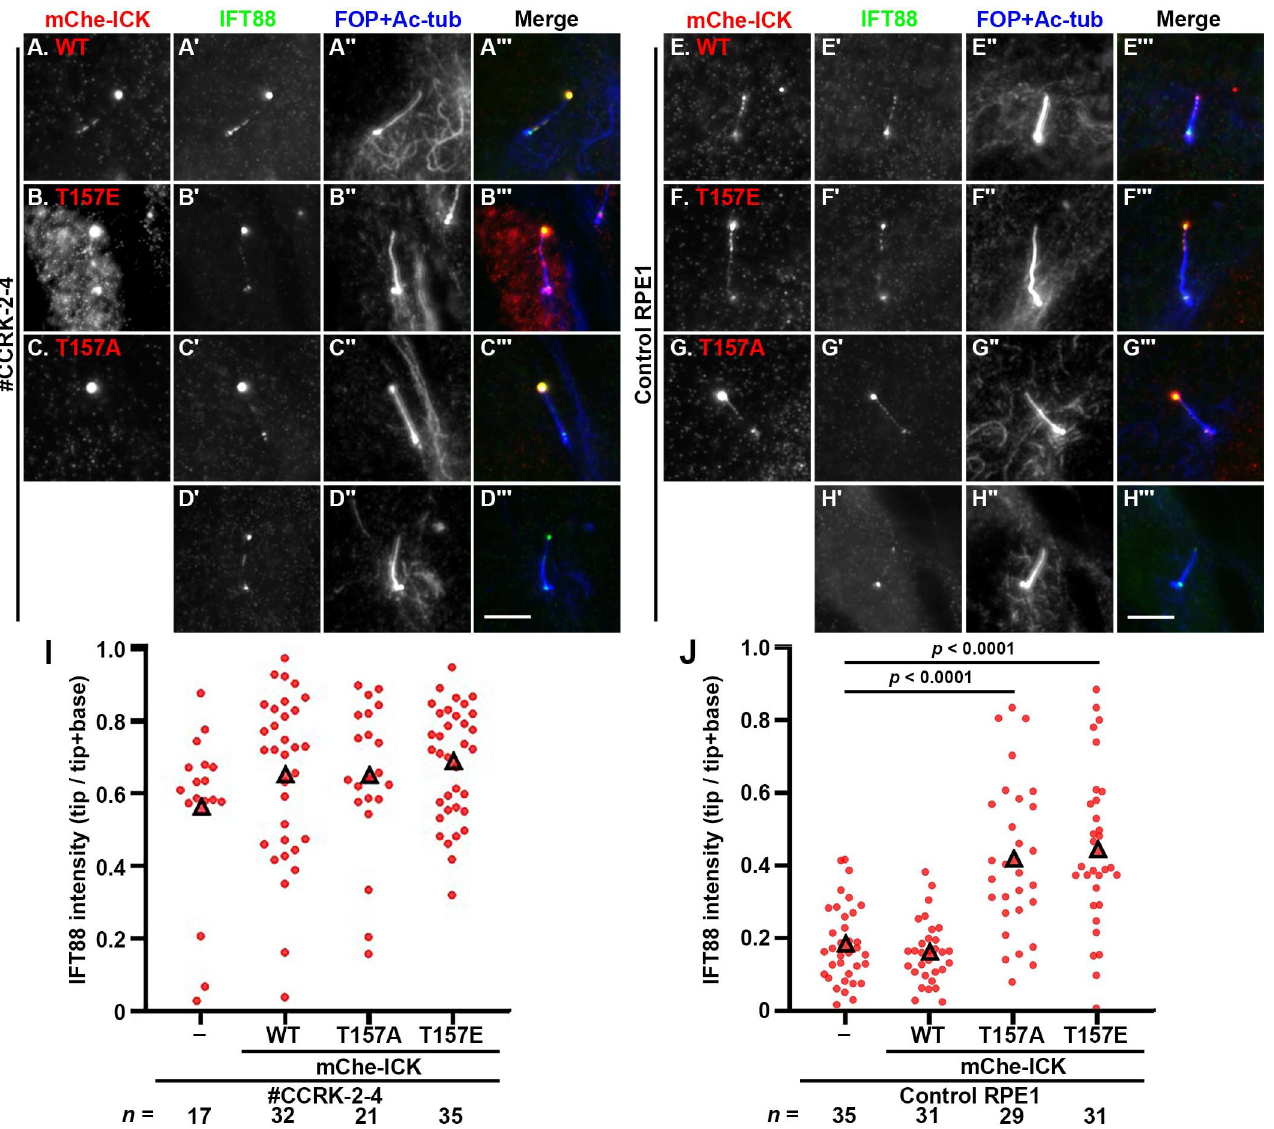
Fig 6. ICK(WT) and its phosphorylation site mutants were unable to rescue the abnormal phenotypes of CCRK -KO cells. CCRK -KO cells (#CCRK-2-4) (A– D) or control RPE1 cells (E–H) expressing mChe-fused ICK(WT) (A, E), ICK(T157E) (B, F), or ICK(T157A) (C, G) were immunostained for IFT88 (A 0 –H 0 ) and FOP+ Ac-tubulin (A 00 –H 00 ). The original CCRK -KO cells and RPE1 cells were also stained for IFT88 and FOP+ Ac-tubulin. Scale bars, 5 μ m. (I, J) Relative staining intensities of IFT88 at the ciliary tips and base in the cells shown in (A)–(D) and (E)–(H), respectively, were analyzed as described in the legend for Fig